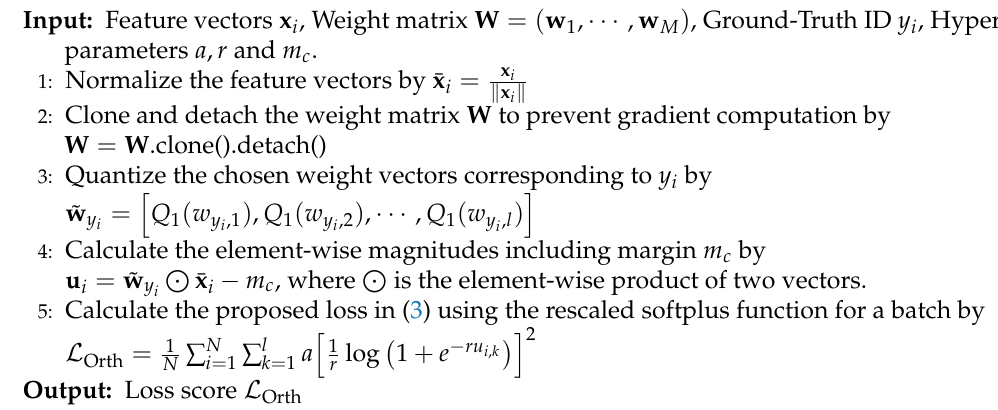
Algorithm 1 The pseudo-code of Orthant loss L